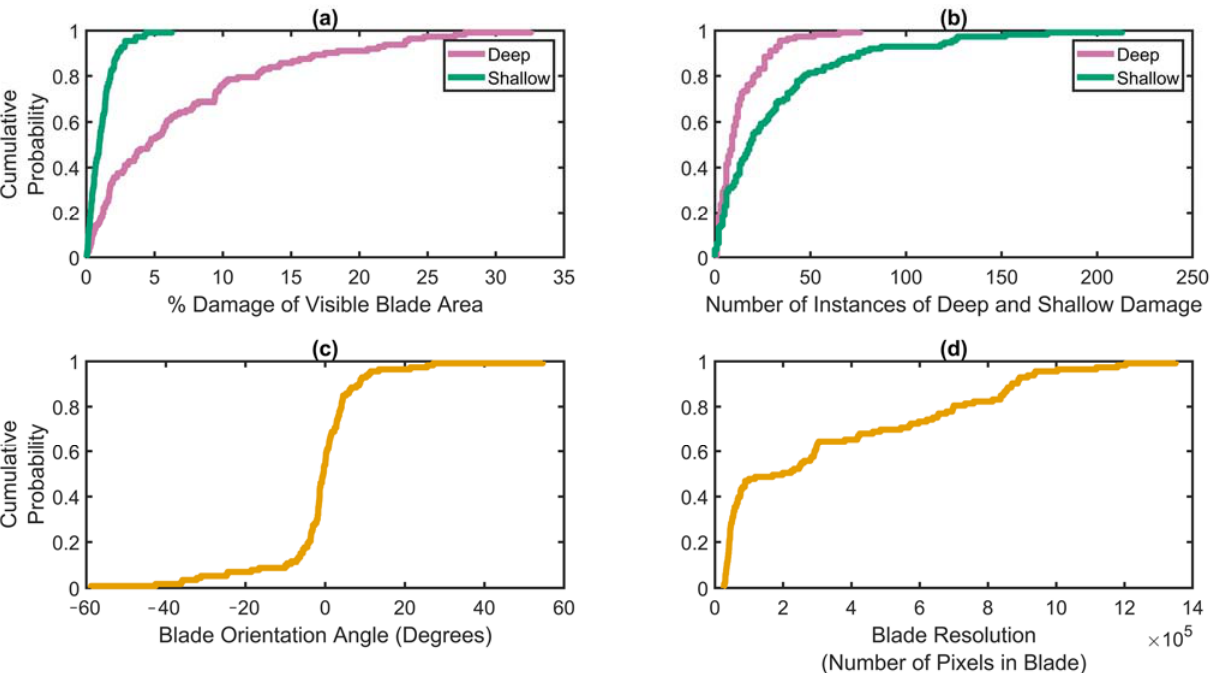
Figure 2. Empirical cumulative density functions (CDFs) of the 140 images in terms of: ( a ) the fraction of the blade area that exhibits shallow (green) and deep (magenta) LEE, ( b ) the number of discrete instances of shallow and deep LEE, ( c ) orientation of the leading edge within the image (where 0° indicates the blade is horizontally aligned within the image), ( d ) blade resolution, defined as the number of pixels in each image that contain the blade.